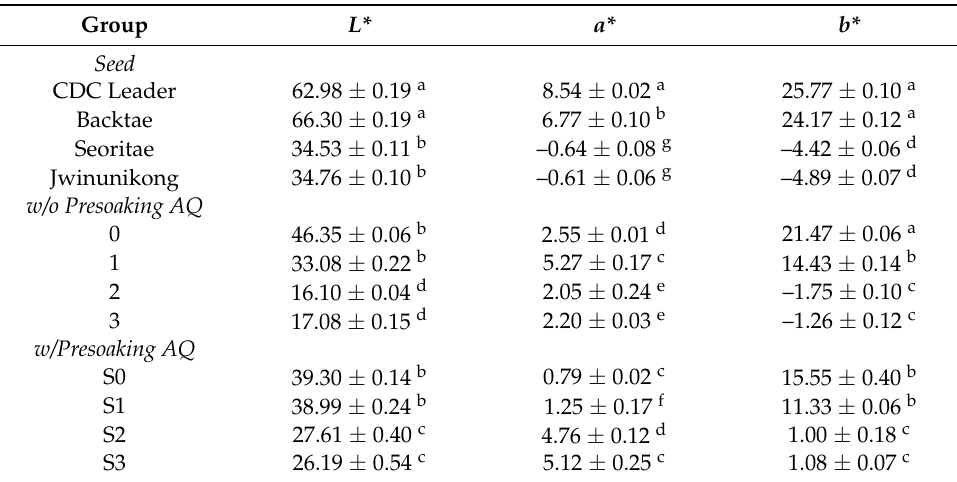
Table 3. Color parameters of all samples used for AQ production. Group